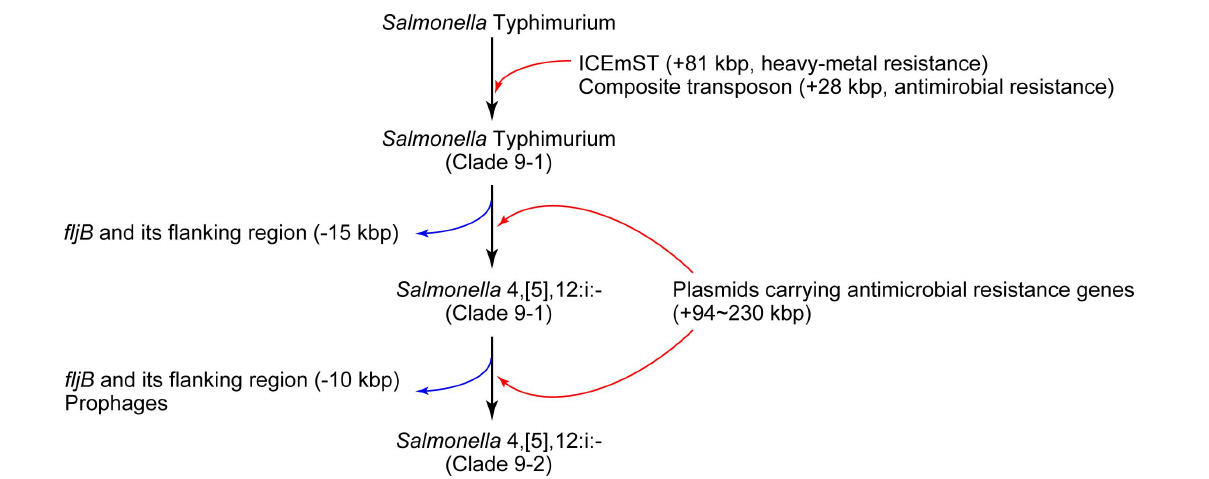
Frontiers in Microbiology |